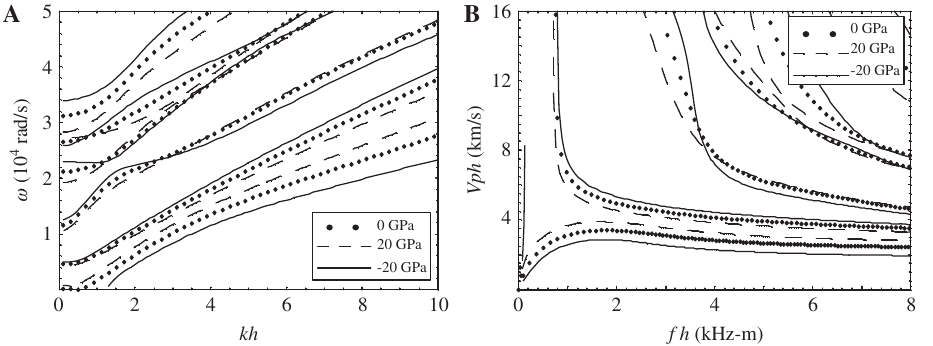
Figure 3 Circumferential Lamb-like wave dispersion curves for the linearly graded cylindrical plate with η = 2 under different radial initial stresses: (A) frequency spectra, (B) phase velocity spectra.